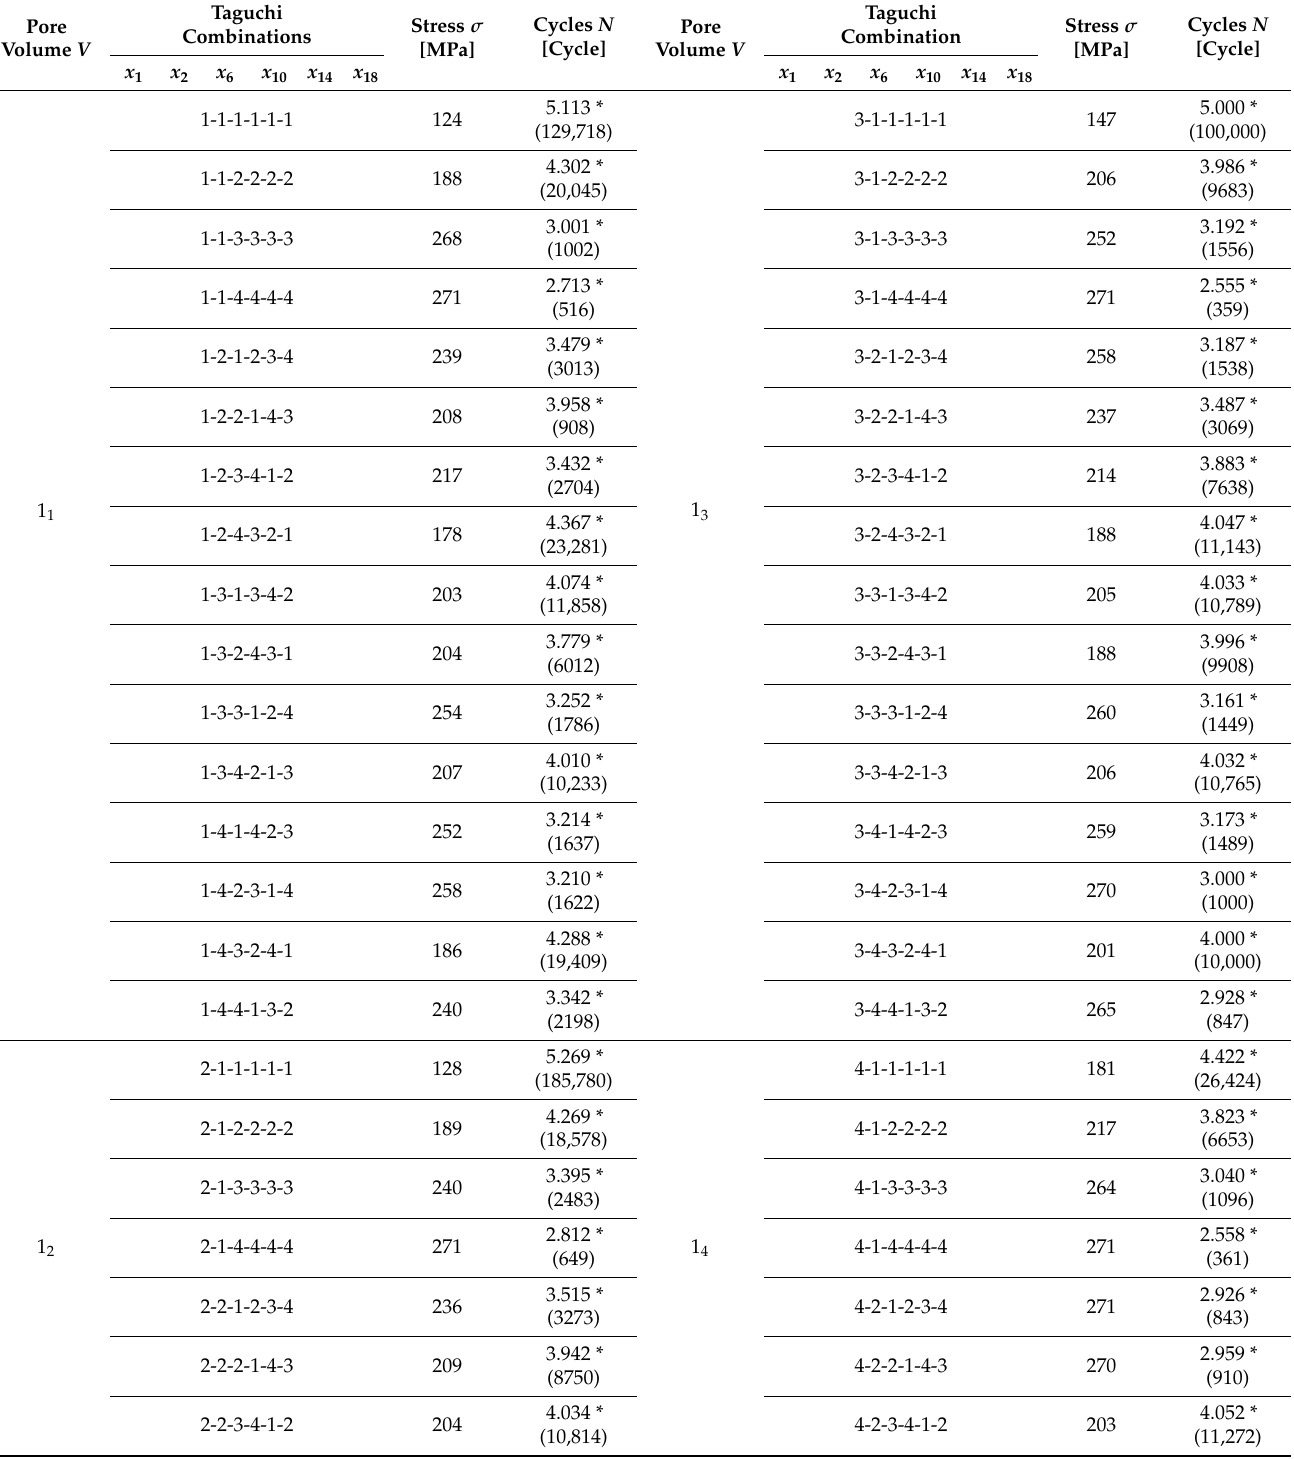
Table 3. Prediction of stress magnitude σ and fatigue lives N for different pore